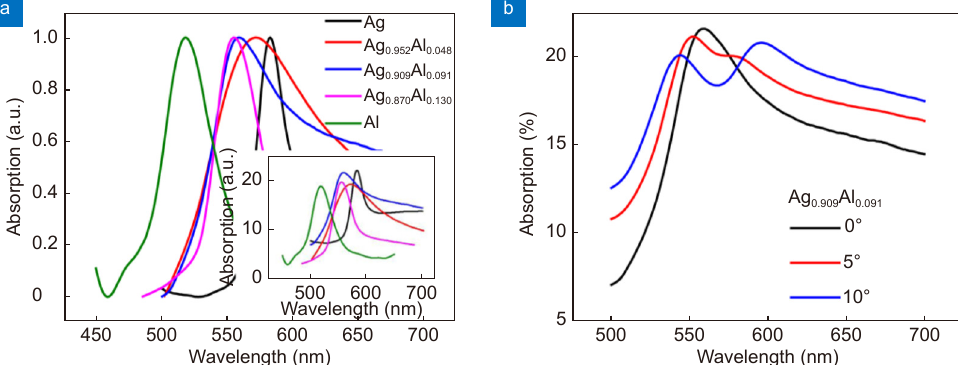
Fig. 4 | ( a ) The normalized absorption spectra of OLEDs based on Ag cathode (black line), Al cathode (green line), Ag 0.952 Al 0.048 alloy cathode (red line), Ag 0.909 Al 0.091 alloy cathode (blue line), and Ag 0.870 Al 0.130 alloy cathode (magenta line), respectively. ( b ) The angle-dependent absorp- tion spectra of OLEDs based on Ag 0.909 Al 0.091 alloy cathode. The inset in (a) shows the absorption spectra of OLEDs based on various cathodes without